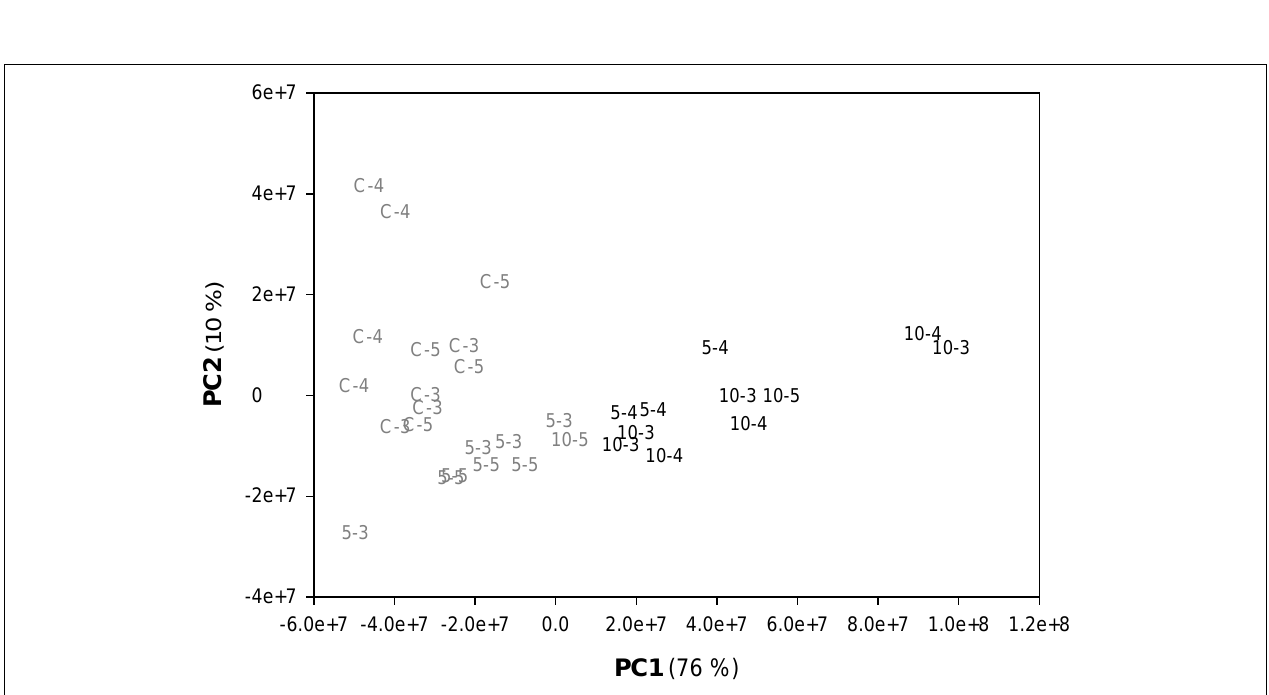
FIGUREA2 | PCA score plot of PC1 vs PC2 of the HPLC-ESI-MS obtained from plant setA. Gray numbers: Group A, black numbers: group B according to cluster analysis. Letters and numbers are coded as: 10–3: 10 = arsenate concentration in nutrient solution (1000 μ gkg − 1 ); 3 = pot number, there were four plants in one